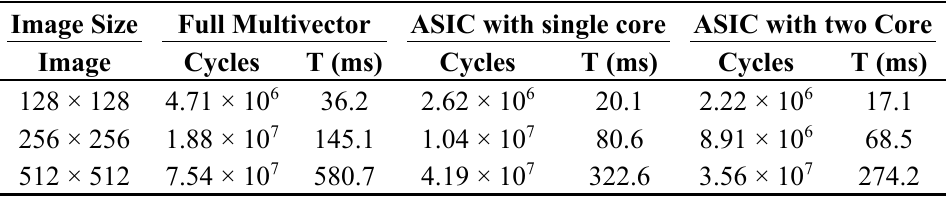
Table 8. Four geometric additions for rotor convolution.